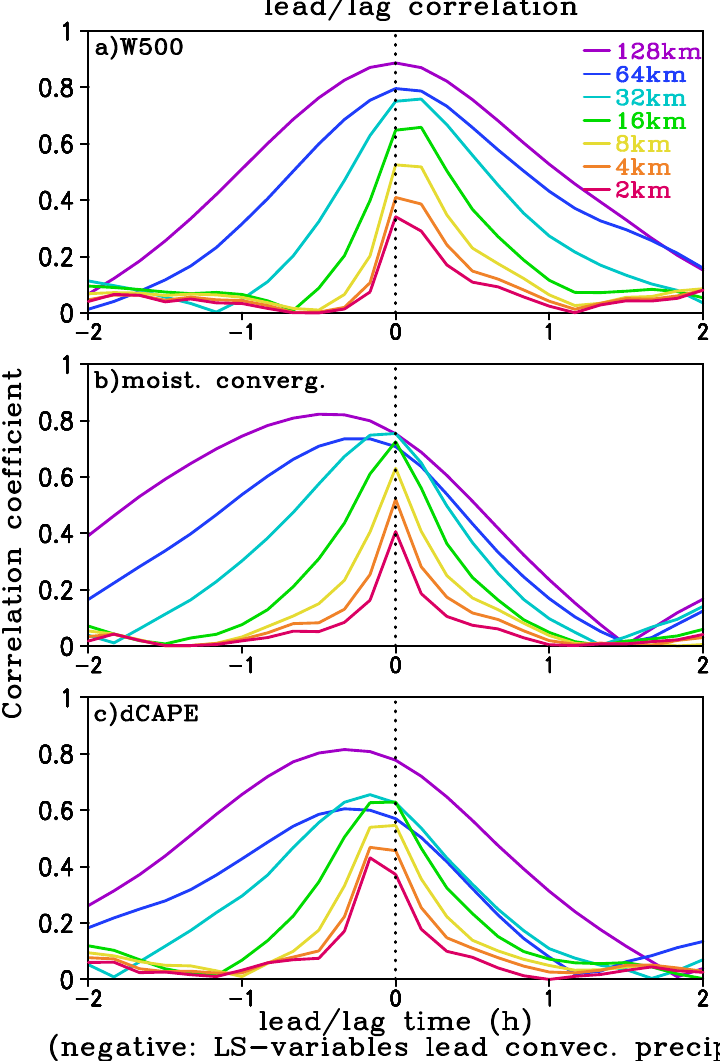
Figure 11. Lead/lag correlation between convective precipitation and ( a ) vertical velocity at 500 hPa, ( b ) moisture convergence and ( c ) large-scale CAPE change for various subdomains. Negative (positive) values on x-axis represent the large-scale forcing leading (lagging) convective precipitation. Table 1. Maximum correlation coefficients between convective precipitation and coarse-grained global climate model (GCM) equivalent variables.